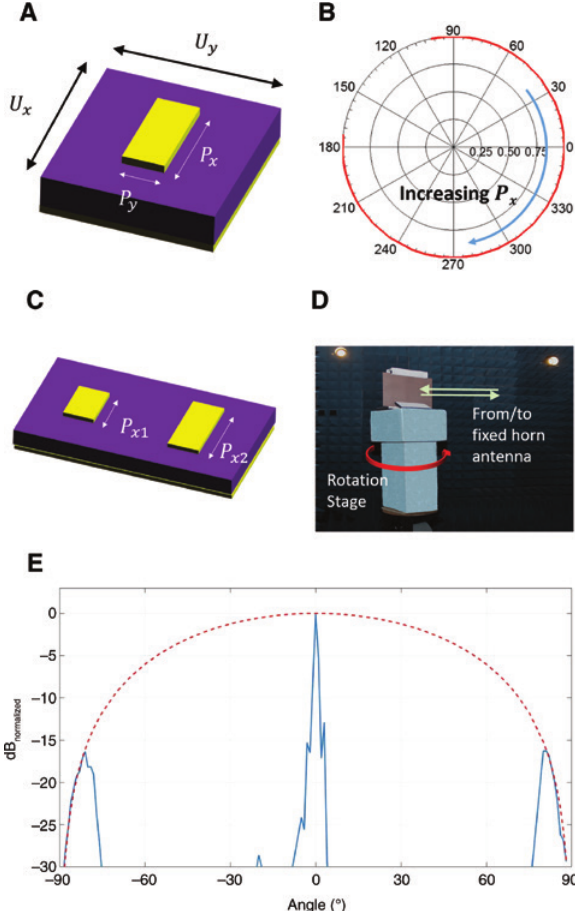
Figure 17: Design and experiment of the retroreflection BHM. Obtained from [82].